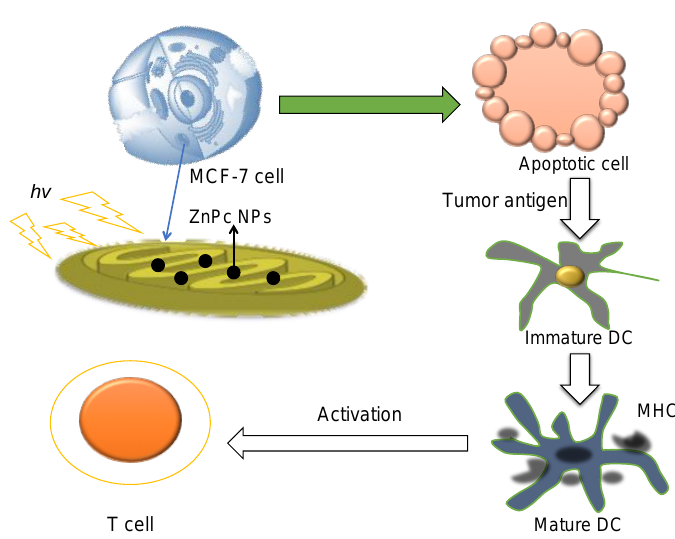
Figure 2. The schematic diagram of action of mitochondria targeted ZnPc NPs. Redrawn from Reference [21].